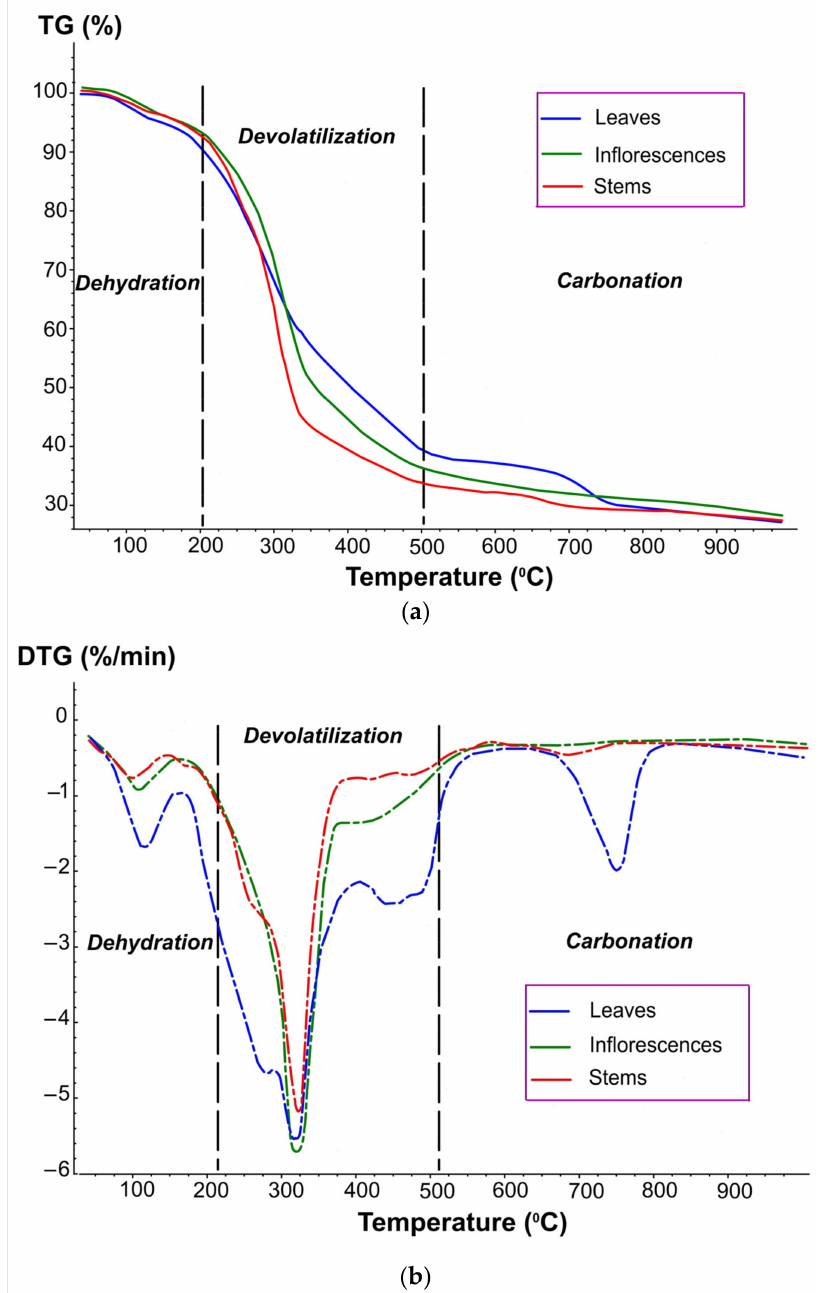
Figure 3. TG ( a ) and DTG ( b ) curves of the AR biomass at a heating rate of 10 ◦ C/min.